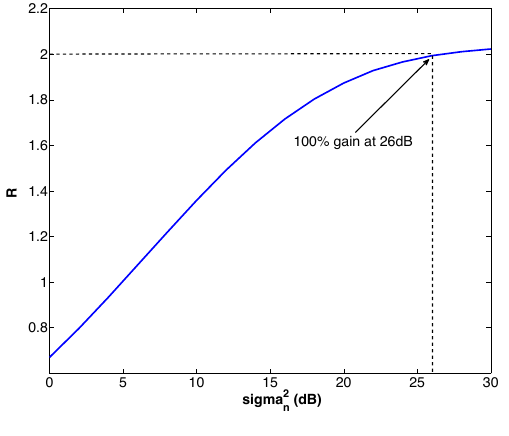
Figure 9. Rate Performance compared to TDMA (MIMO BC) for 𝑐 = 0 . 0255 . For SNR values >5dB, the hybrid schemes outperforms TDMA.